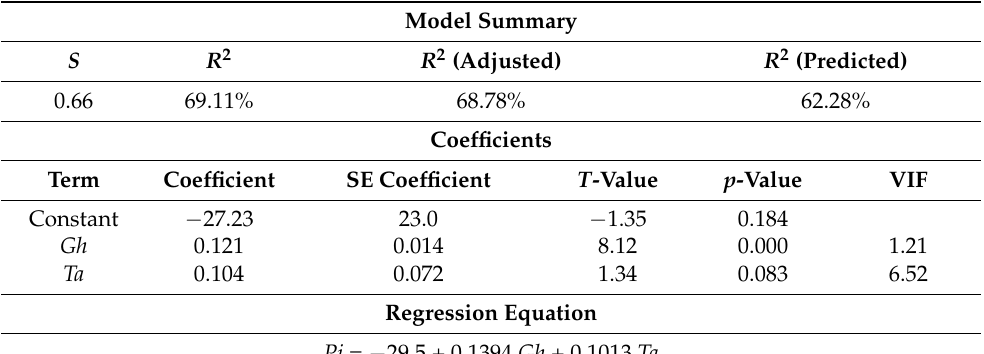
Table 7. Model summary for the mod-still (Model 3).